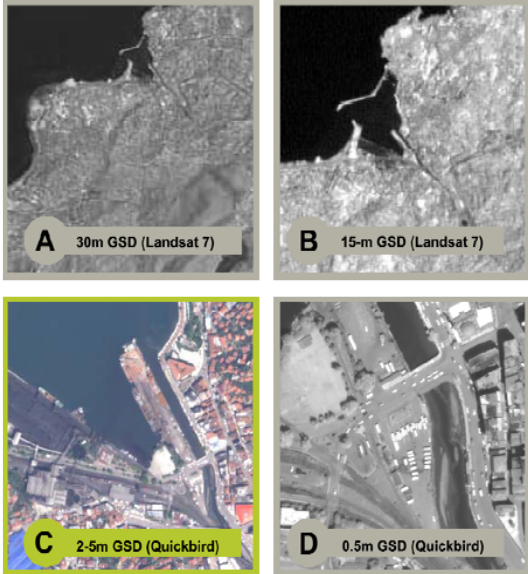
Figure 3. OmniEarth balances image resolution with the data demands of continuous imaging. Our planned constellation will feature 2-5m GSD multispectral images (Panel C), providing maximum value for our customers. Images show Zonguldak, Turkey from Topan, Büyüksalih and Jacobsen (2005).